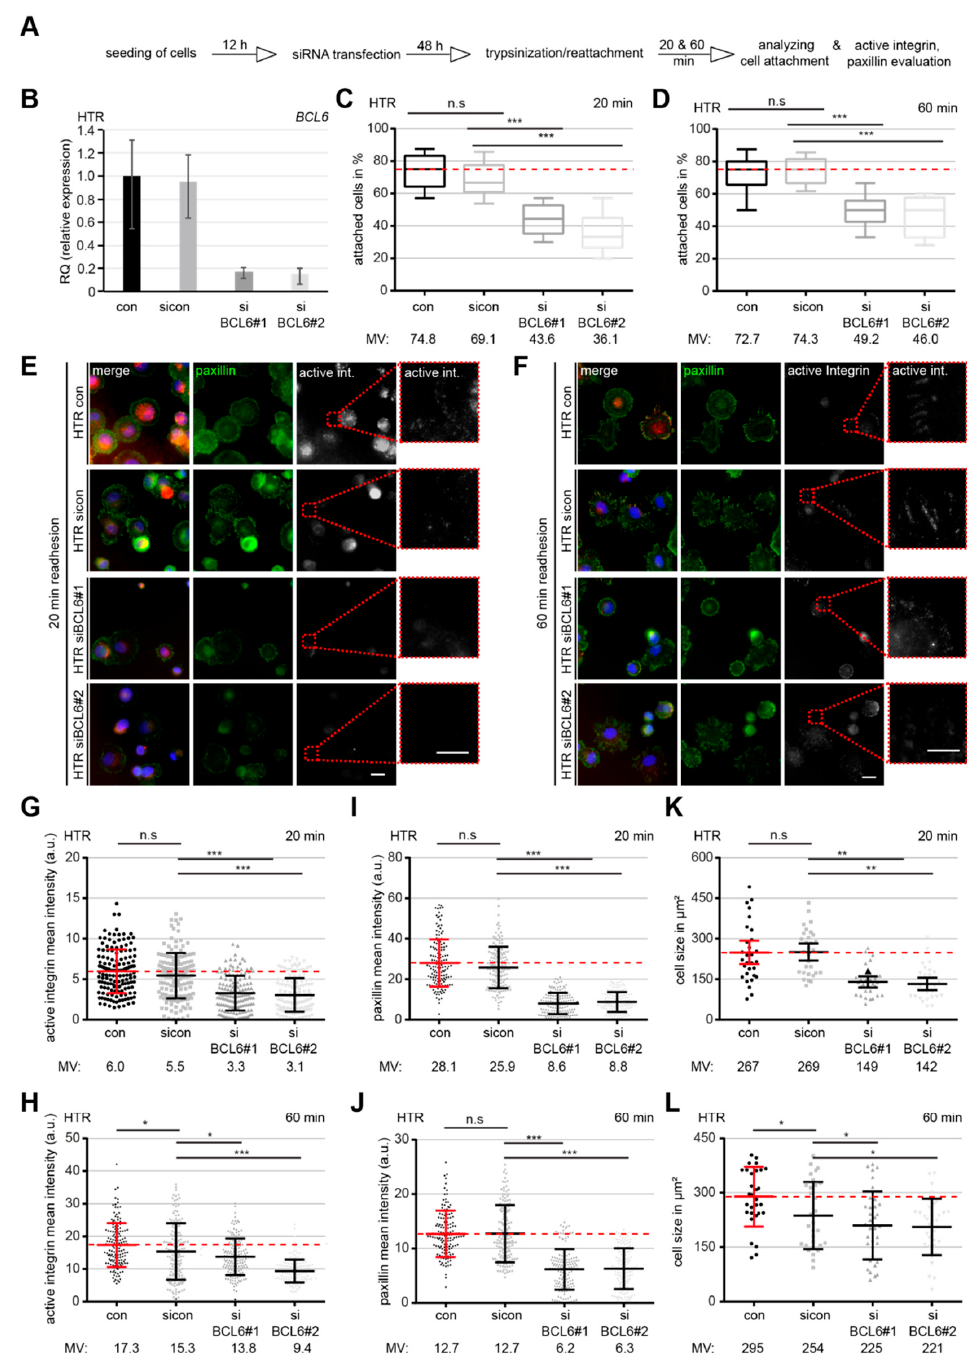
Figure 3. Cell adhesion and integrin activation are compromised upon BCL6 depletion. ( A ) Schedule of the cell spreading/adhesion assay. HTR cells were treated with sicon, siBCL6#1, or siBCL6#2. Forty-eight hours later, treated cells were trypsinized and reseeded for 20 or 60 min for a further evaluation of attached cells or for immunofluorescence staining. ( B ) The BCL6 gene levels were measured in treated cells as transfection efficiency controls. ( C ) Evaluation of attached cells at 20 min after reseeding (300 cells). The results are based on three independent experiments and presented as box plots. *** p < 0.001. ( D ) Quantification of attached cells at 60 min after reseeding. The results were obtained from three independent experiments and are shown as box plots, with bars indicating variable sizes (300 cells). *** p < 0.001. ( E , F ) Attached cells at 20 min ( E ) and 60 min ( F ) after reseeding were also stained for focal adhesion (FA) markers paxillin and active integrin, as well as DNA, for